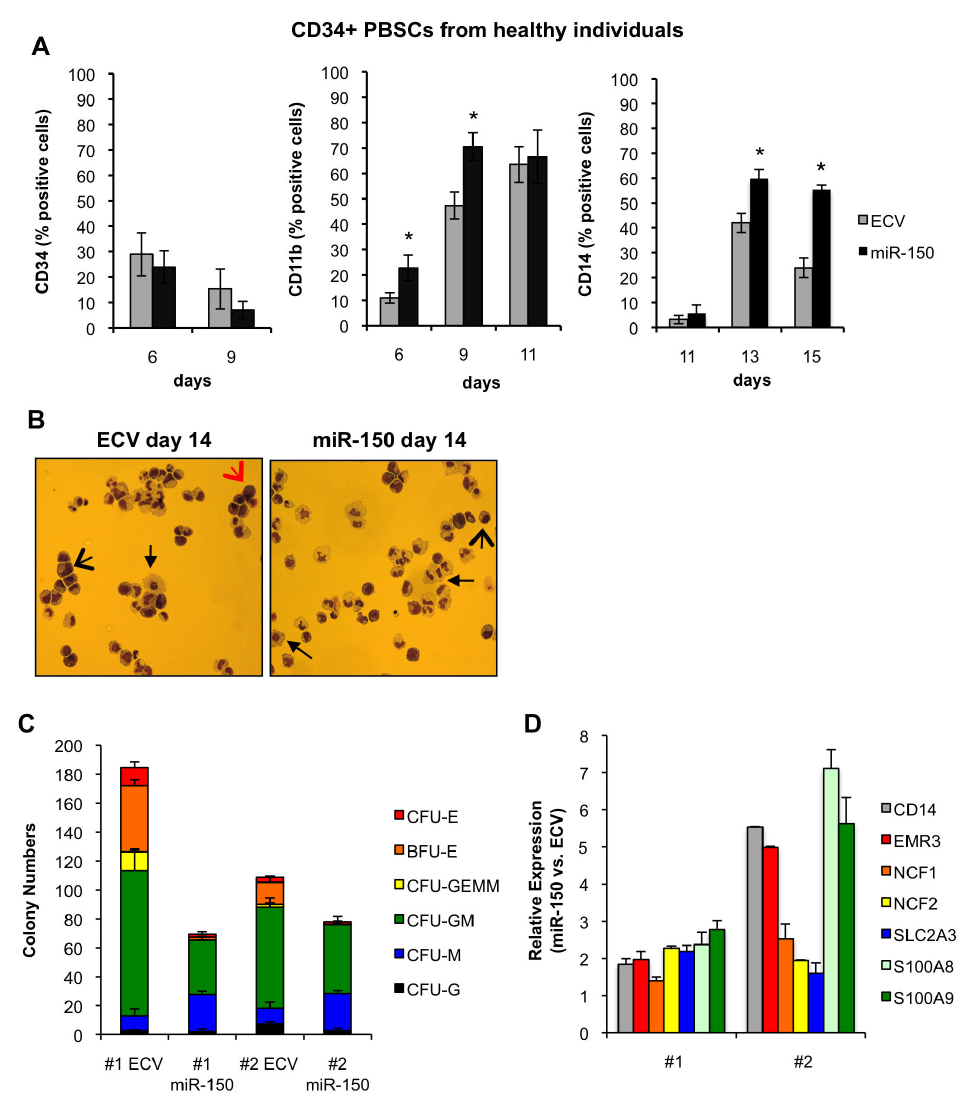
Figure 3. MiR-150 expression promotes myeloid differentiation of CD34+ PBMCs from healthy donors. Primary CD34+ PBMCs were transduced with pre-miR-150 or empty control lentiviral (ECV) supernatants, sorted for GFP expression, and then assayed by flow cytometry for CD11b, CD34, and CD14 expression or colony formation by colony-forming unit (CFU) assays. (A) Cells were assessed by flow cytometry at the indicated days after cell transduction cultured in the presence of rhSCF, rhIL3, rhIL6, rhGCSF, rhGMCSF (50 ng/ml each), and EPO (2 U/ml). CD11b and CD14 expression increased in both patient samples in the miR-150 vs. control transduced cells, while CD34 did not significantly change. The means from combined patients each run in duplicate experiments are shown; the error bars represent standard deviations (* P≤0 . 05 , for comparisons, Student’s t-test). (B) At day 14 after transduction, miR-150 or ECV transduced CD34+ PBSC were stained with Wright-Giemsa after cytospin preparations and showed morphological evidence of myeloid differentiation, including immature cells (large red arrows), intermediate differentiated cells (large black arrows), and mature myeloid cells (small black arrows). (C) Cells were sorted and plated in triplicate 3 days post transduction in Methocult™ containing 20% lot-tested FBS, 10% BSA, and cytokine concentrations as above. Colonies were counted 12-16 days after plating. The mean colony numbers from triplicate plates are shown for each patient sample (#1 or #2); error bars indicate standard deviations. MiR-150 transduced cells had significantly lower colony numbers compared to control transduced cells, with decreased erythroid colonies (BFU-E and CFU-E), decreased CFU-G and CFU-GM, but increased monocyte/ macrophage colonies (CFU-M) ( P≤0.05 for comparisons, Student’s t-test). (D) Expression of genes associated with myeloid differentiation was assessed in both CD34+ PBSC patient samples transduced with either miR-150 or ECV 9 days after transduction by QPCR. Relative fold-difference in expression for miR-150 vs. ECV cells is displayed for each patient sample; error bars represent standard deviations of technical duplicates. doi: 10.1371/journal.pone.0075815.g003 PLOS ONE |